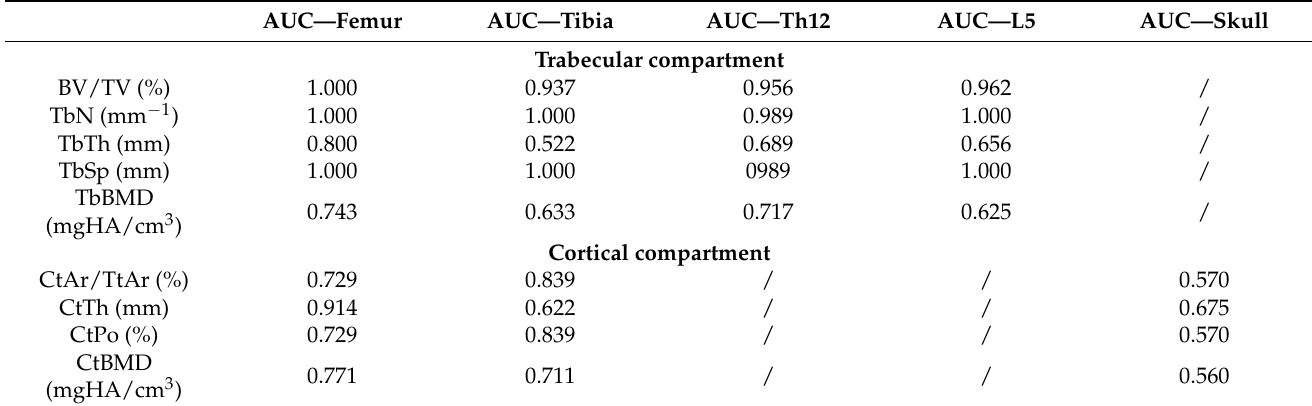
Table 3. Area under the curve of the trabecular and cortical compartments for all tested